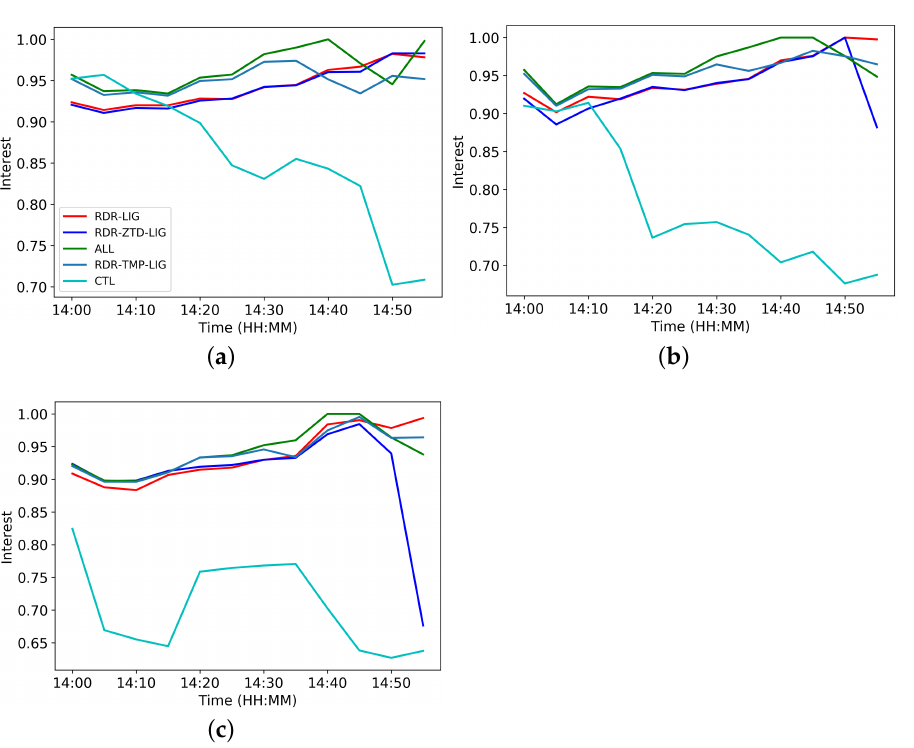
Figure 7. Evolution of the interest from 14:00 UTC to 14:55 UTC (closure of the airport) for the threshold values 3 kg m − 2 ( a ), 5 kg m − 2 ( b ) and 7 kg m − 2 ( c ), respectively. The CTL simulation is represented by the cyan line, while RDR-LIG, RDR-ZTD-LIG, RDR-TMP-LIG and ALL simulations are colored red, blue, pink and green,